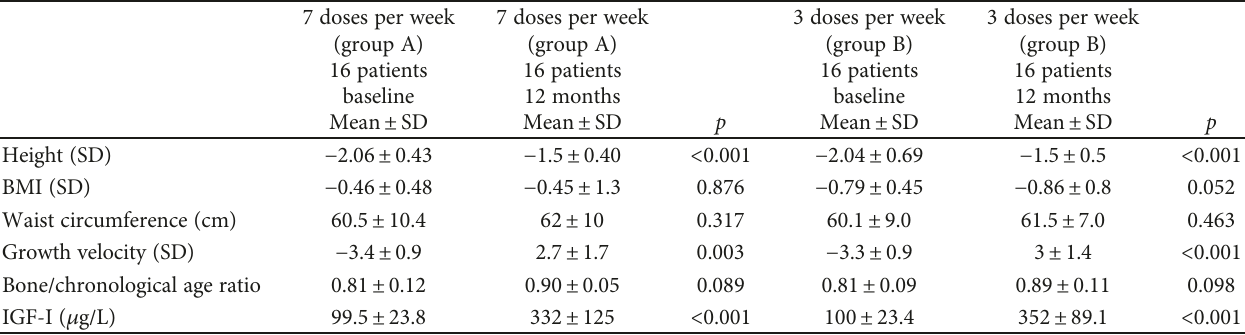
Table 1: Clinical and biochemical features of patients grouped according to the GH treatment regimen (group A and group B) at baseline and after 12 months of treatment.